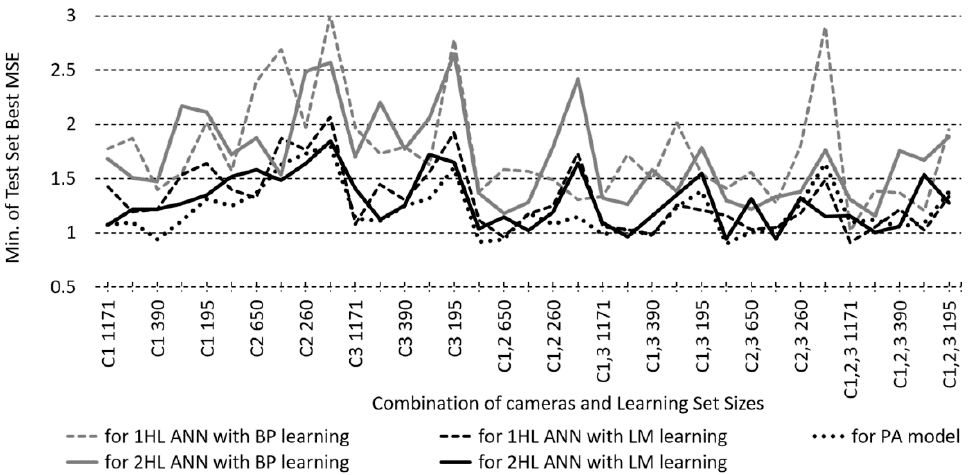
Figure 9. Comparison of test set average CIEDE2000 colour differences with illuminant A (A ∆ E* 00 _A) for ANN and PA models which exert the best MSE of the test set, according to one and two hidden layer ANNs (1/2HL) modelled with BP or LM learning algorithm and for the polynomial approximation models (PA).